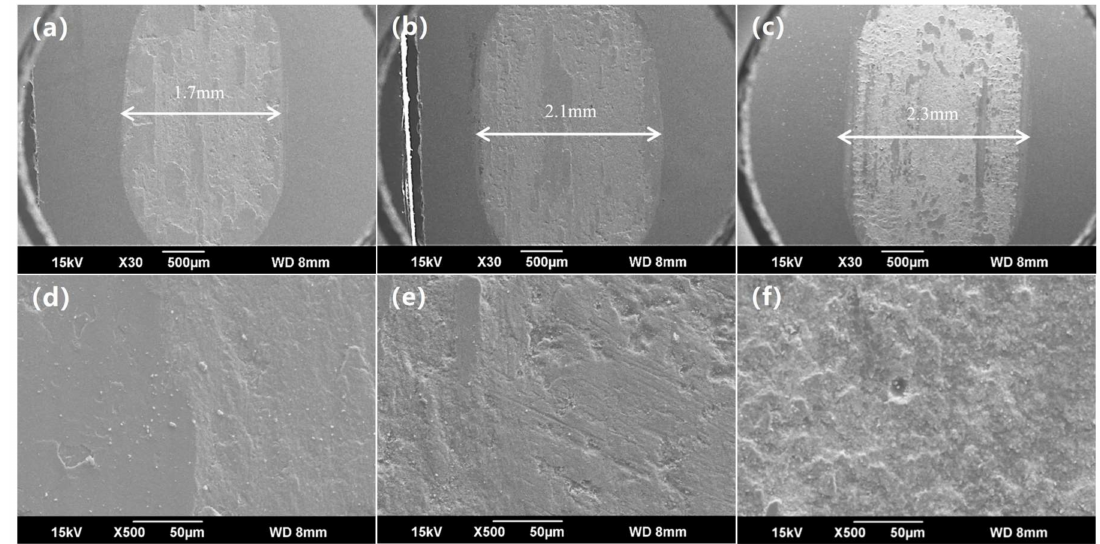
Figure 10. SEM image of the wear trace under the constant load 50 N with different sliding speed. ( a – c ) are the low-magnification images tested at 10 mm/s, 20 mm/s, and 30 mm/s; and, ( d – f ) are the corresponding high-magnification